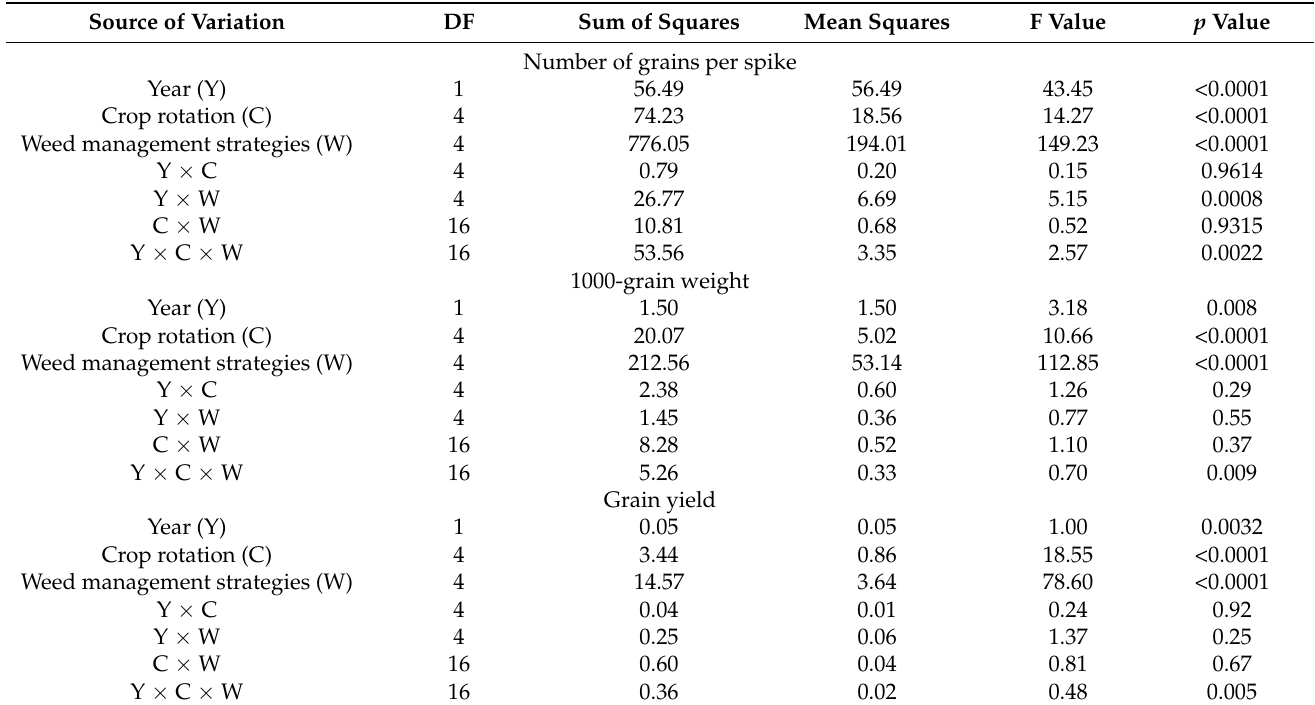
Table 7. Analysis of variance of different yield related traits and grain yield of wheat crop sown in different crop rotations under various weed management